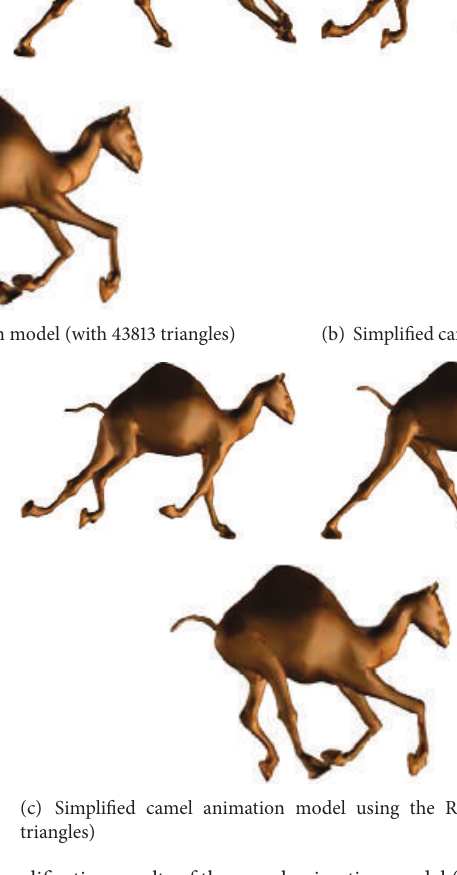
Figure 9: Simplification results of the camel animation model (frame examples 3, 23, and